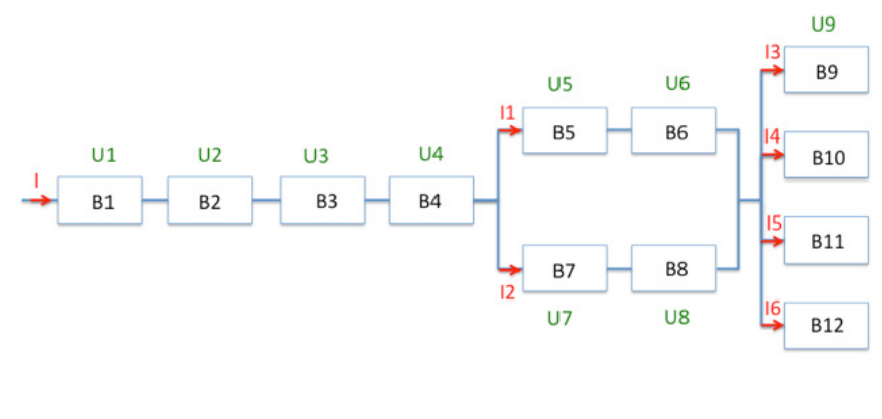
Figure 12. Novel life cycle